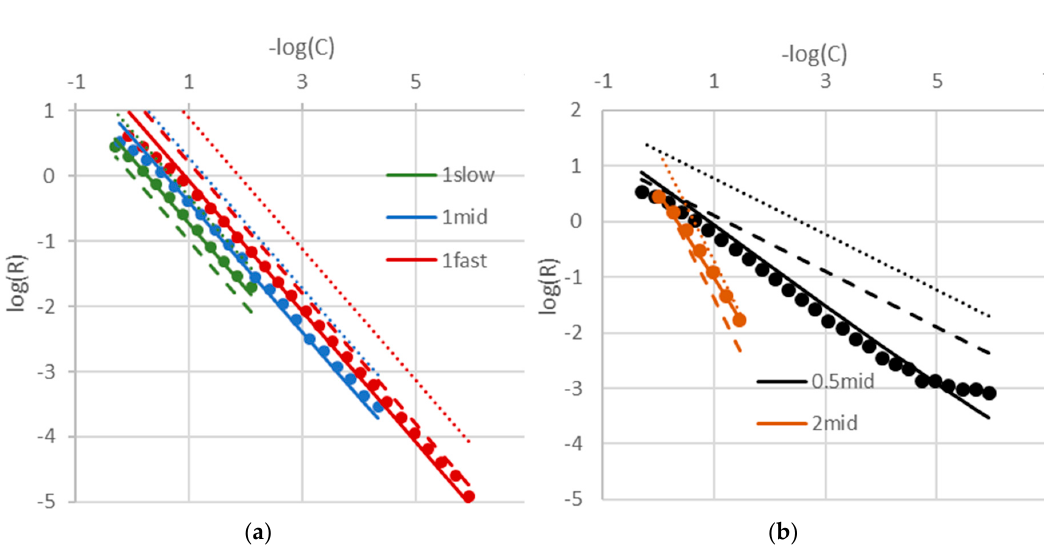
Figure A1. The reaction rate plotted against the concentration, comparing the binned data from resolved simulations (symbols) to model predictions (solid lines) for ( a ) first order and ( b ) other order reactions. The dashed lines show the predictions when using the effectiveness factor from the reference reaction (1 mid) and the dotted line the predictions without an effectiveness factor. Data is shown for the largest filter size considered ( ˆ ∆ f = 10.4) and for an intermediate filtered solids volume fraction ( α s = 0.30